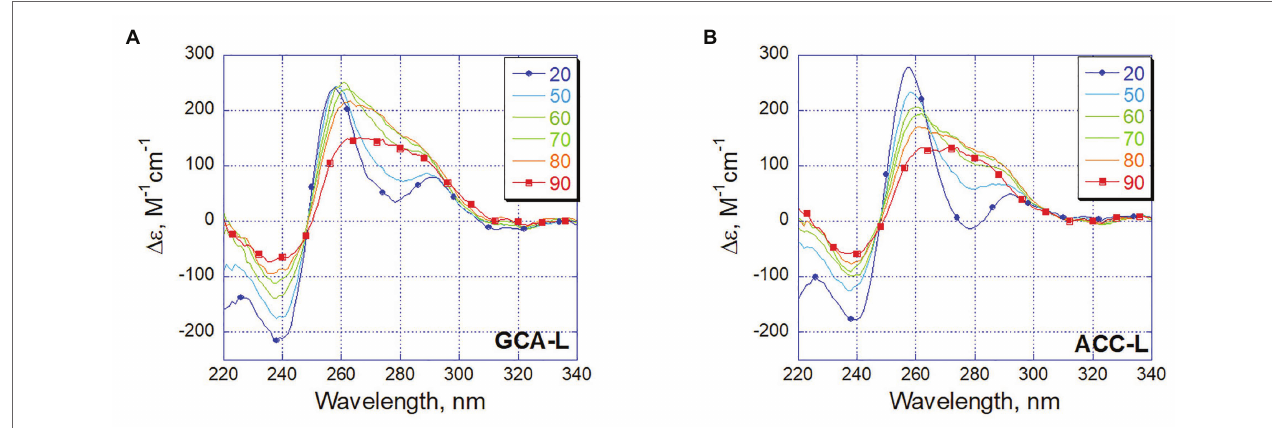
FIGURE 7 | Temperature dependence of CD spectra for long oligonucleotides GCA-L (A) and ACC-L (B) . Temperature color code shown on insert from blue (20 ° C) to red (90 °